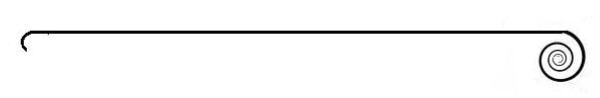
Revealing the presumed design of the wire with its distal end coiled instead of being straight to prevent slippage of the wire.